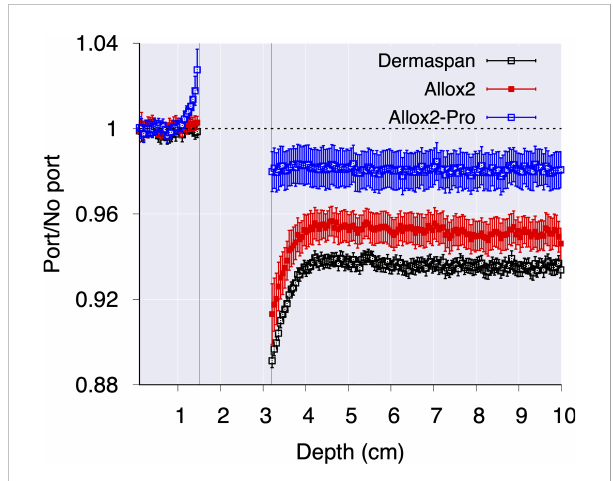
FIGURE 5 The effect of metal port calculated with MC simulations for the three breast tissue expander models.